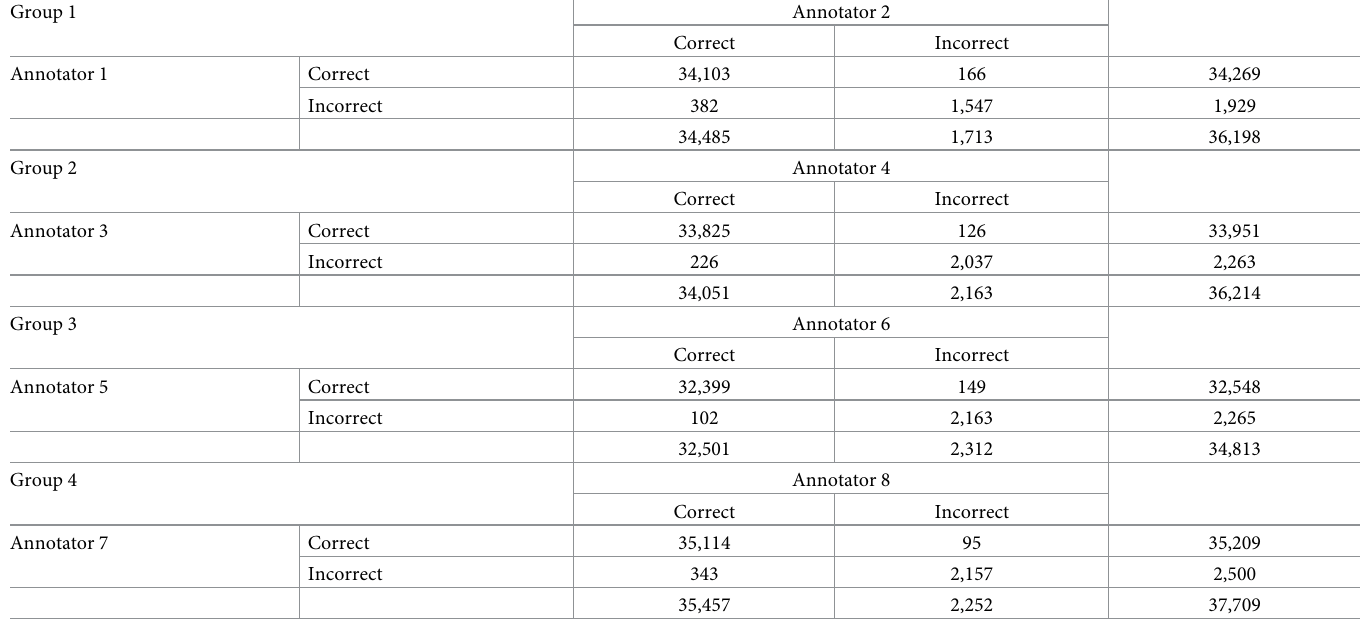
Table 6. Annotation results for Group 1 to